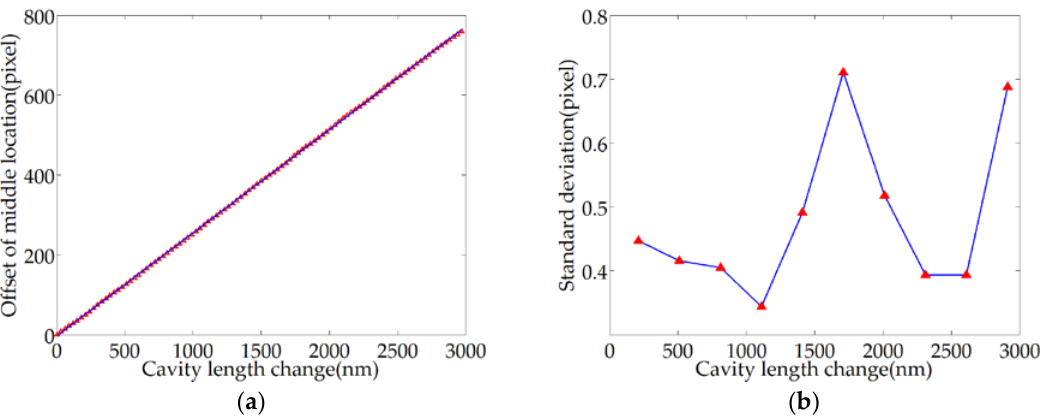
Figure 16b. Sensors 2020 , 20 , x